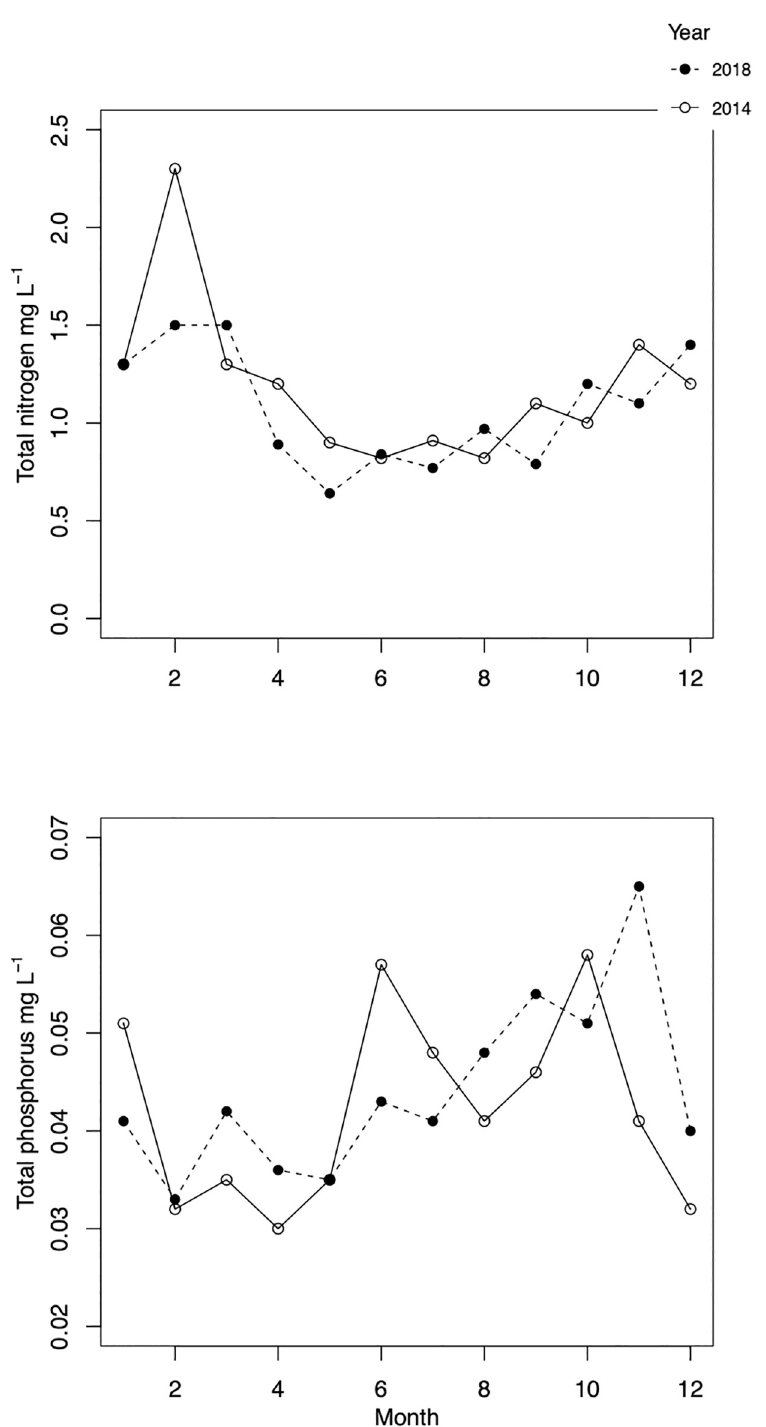
Fig 1. Seasonal dynamics of total phosphorus (TP, mg L -1 , lower) and nitrogen (TN, mg L -1 , upper) in 2014 (solid line, empty circles) and 2018 (dashed line, filled circles).